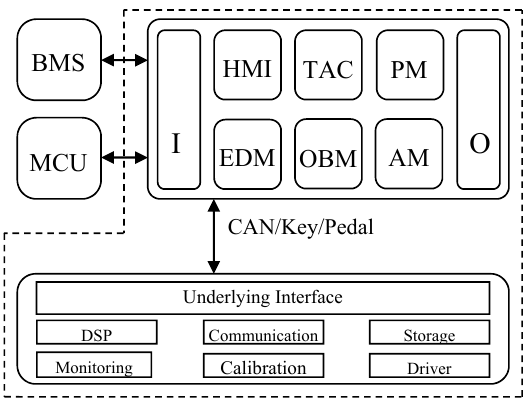
Figure 1. Overall Framework of Controller. (I: Input Signals; HMI: Human Machine Interface; TAC: Torque Arbitration Calculation; PM: Power Management; EDM: Error Diagnosis Management; OBM: Observer Module; AM: Accessories Module; O: Output signals; CAN: Controller Area Netwrk; DSP: Digital Signal Processing).